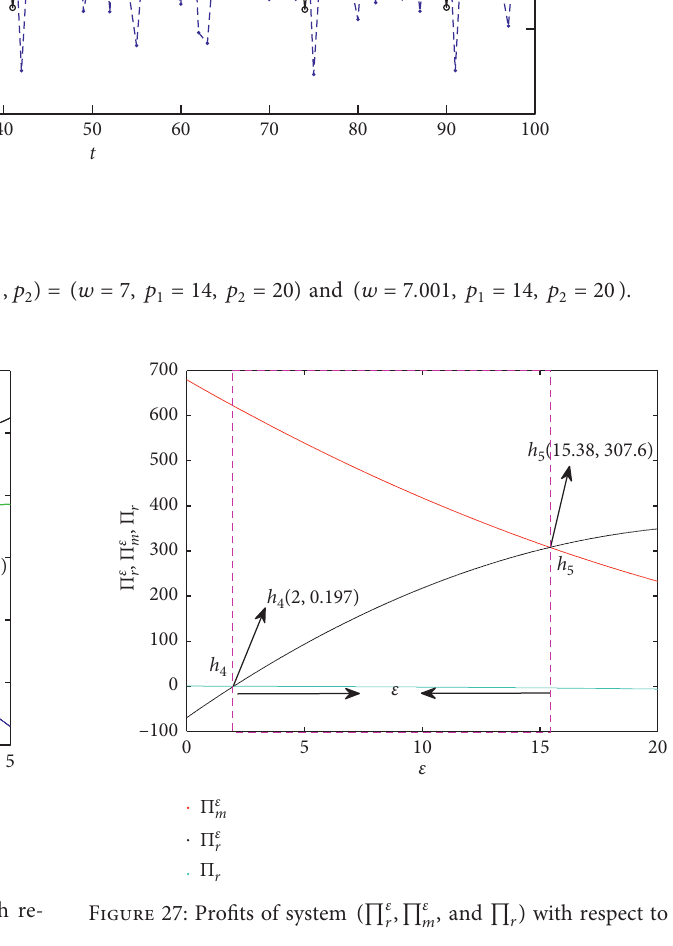
, 􏽑 ε , and 􏽑 ) with respect to ε r r m